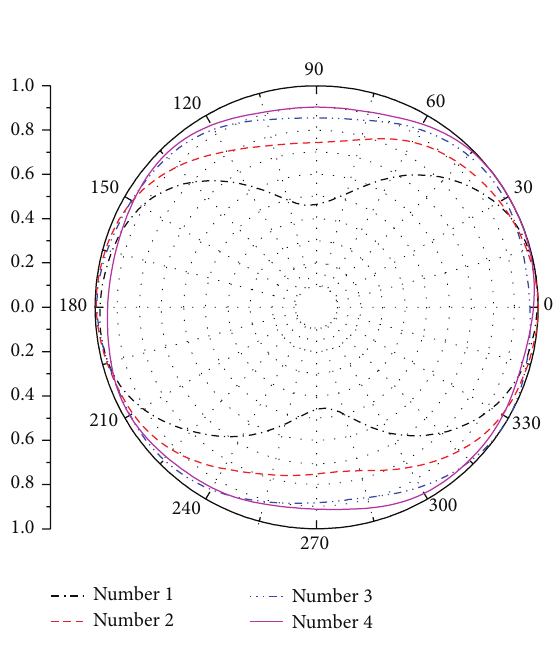
Figure 6: HFSS simulated normalized radiation pattern in 𝑦 - 𝑧